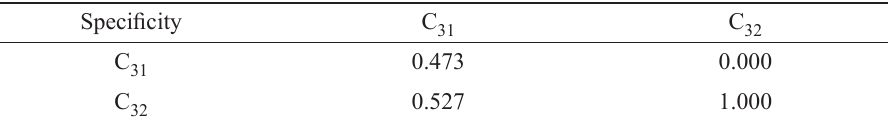
Table 13. The relative importance weights for criteria under the Speci fi city